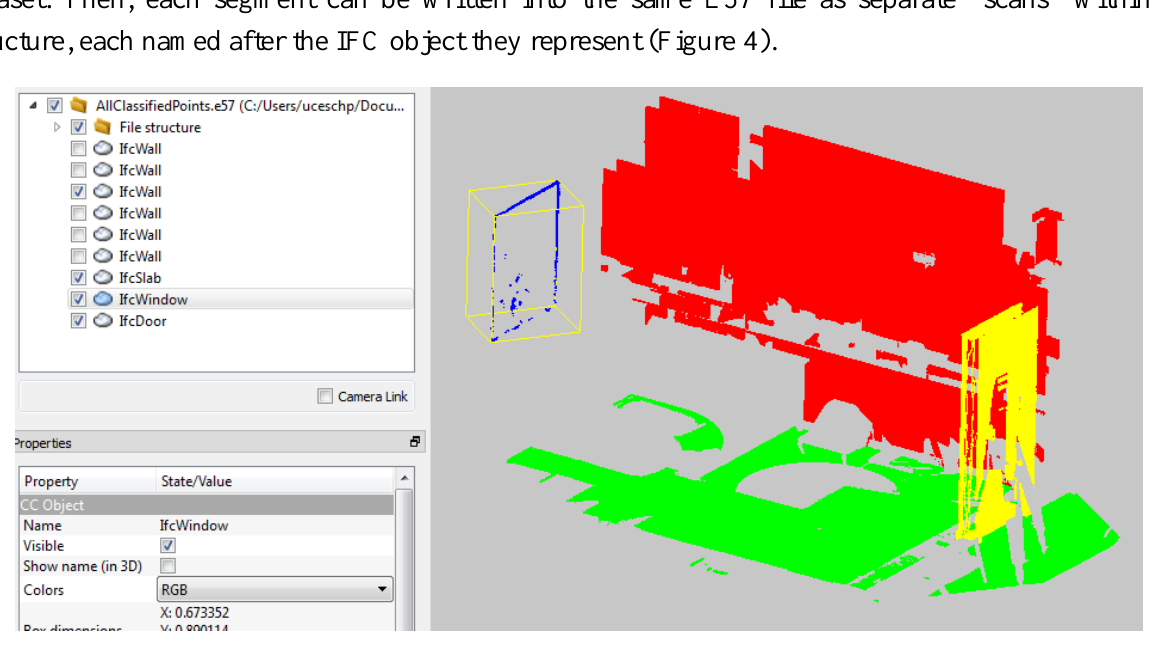
Figure 4. E57 point cloud with each element classified by IFC type (loaded in CloudCompare with four of nine elements